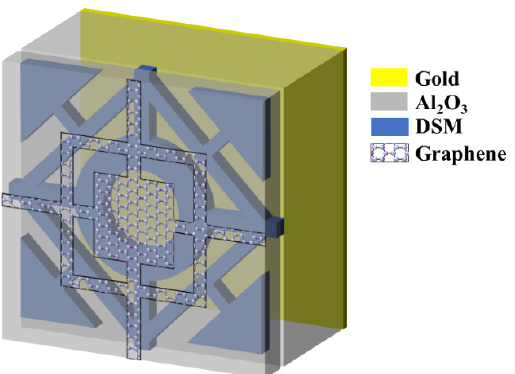
Figure 20. Designed absorber based on the combination of DSM and graphene [169].